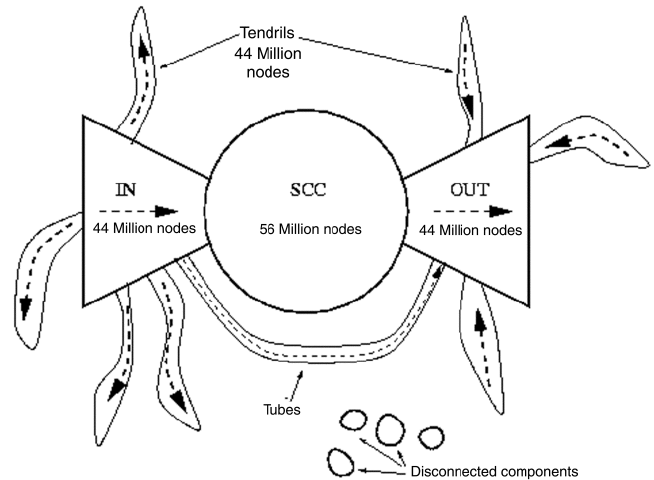
Figure 2. Connectivity of the web, as in